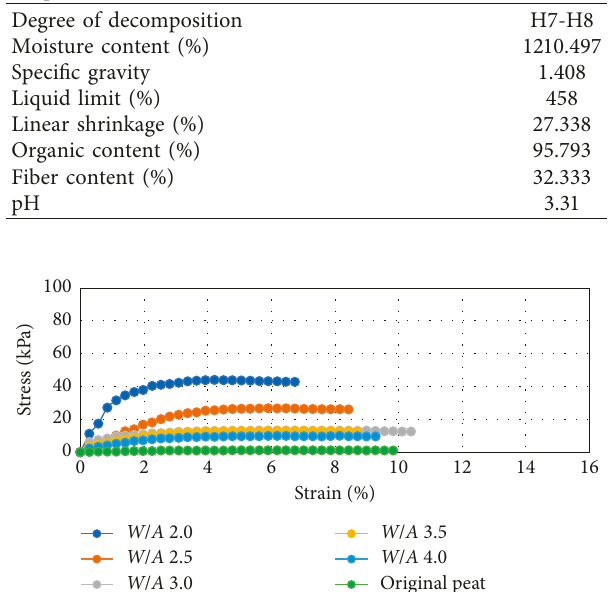
Figure 1: Stress vs. strain of peat A specimens after 28 days air- cured.